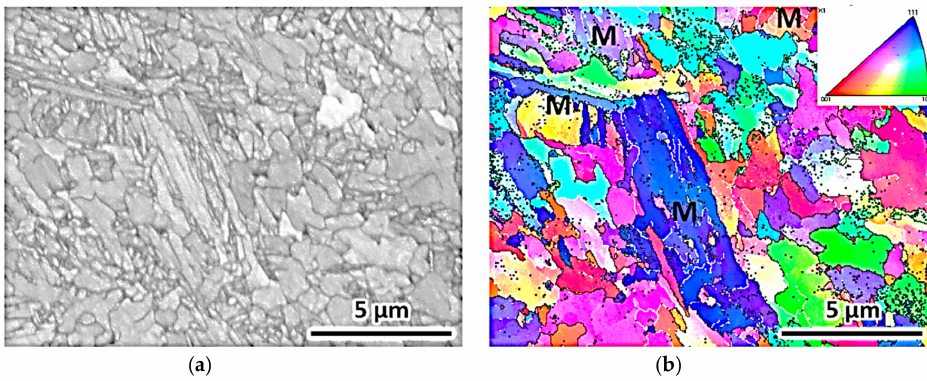
Figure 12. Selected EBSD maps of the sample quenched after the fifth finishing pass with three roughing passes: ( a ) band contrast (pattern quality) map, and ( b ) inverse colored orientation pole figure (IPF)